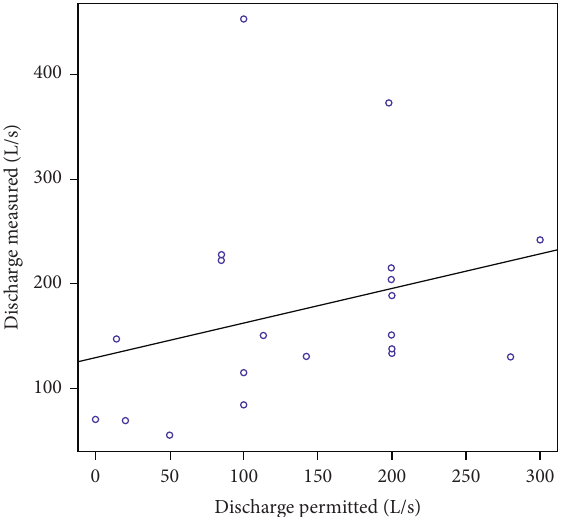
Figure 11: Analysis of discharge measured versus